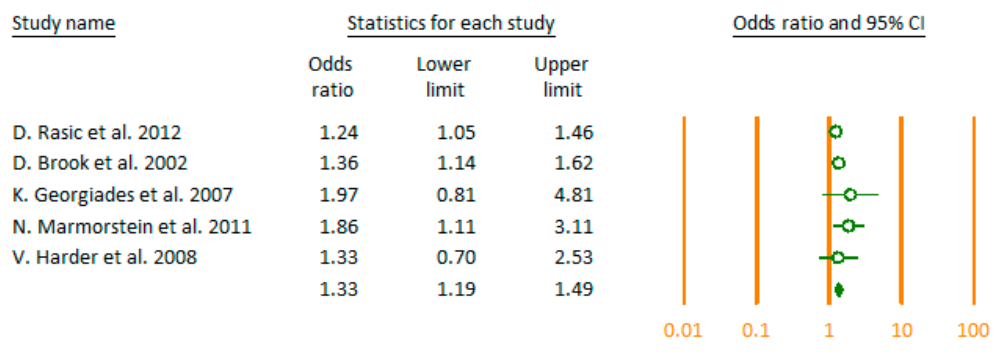
Table 3. Subgroup analysis for mental health disorders and substance use.